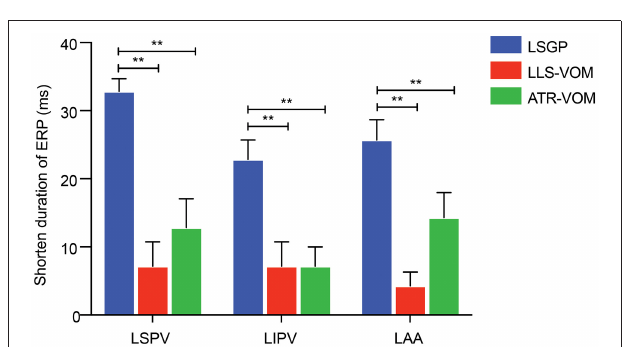
FIGURE 5 | Shorten duration of ERP at LSPV, LIPV, and LAA; ** P < 0.01.